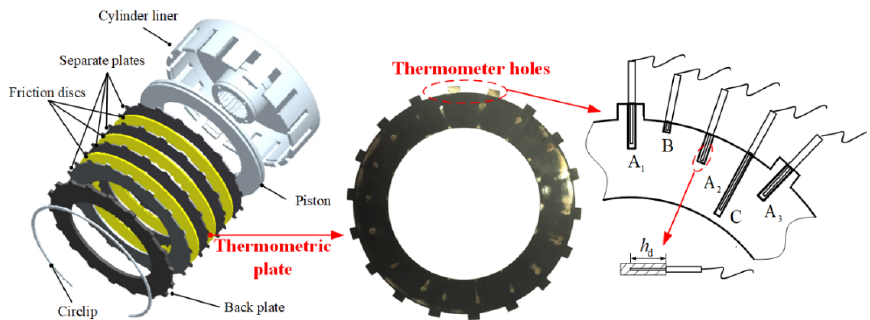
Figure 3. Temperature measurement of the clutch. Table 2. Thermophysical parameters of the wet clutch.